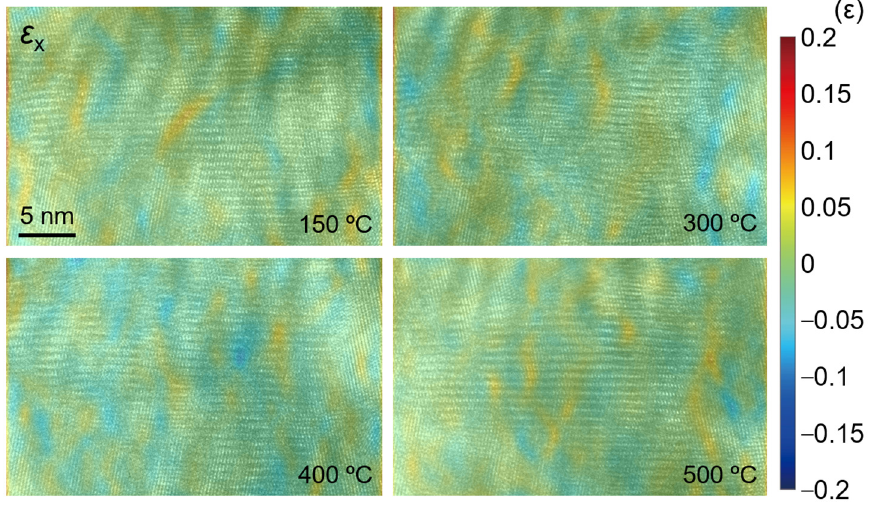
Figure 16. Calculated strain field ε xx .